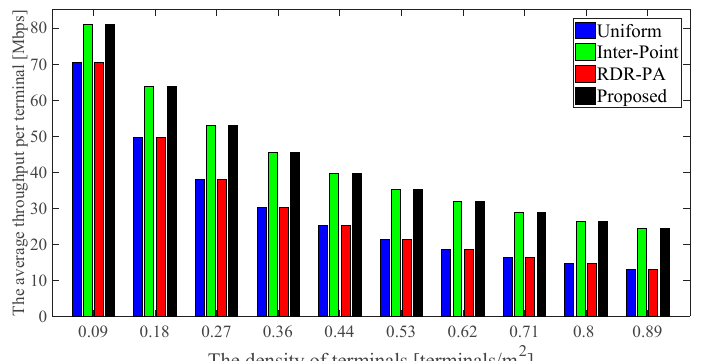
ρ . Figure 3 indicates u